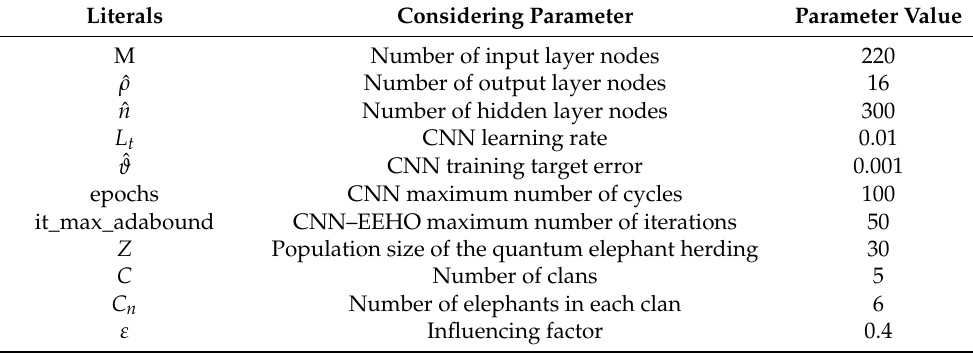
Table 3. The hyper-parameters of